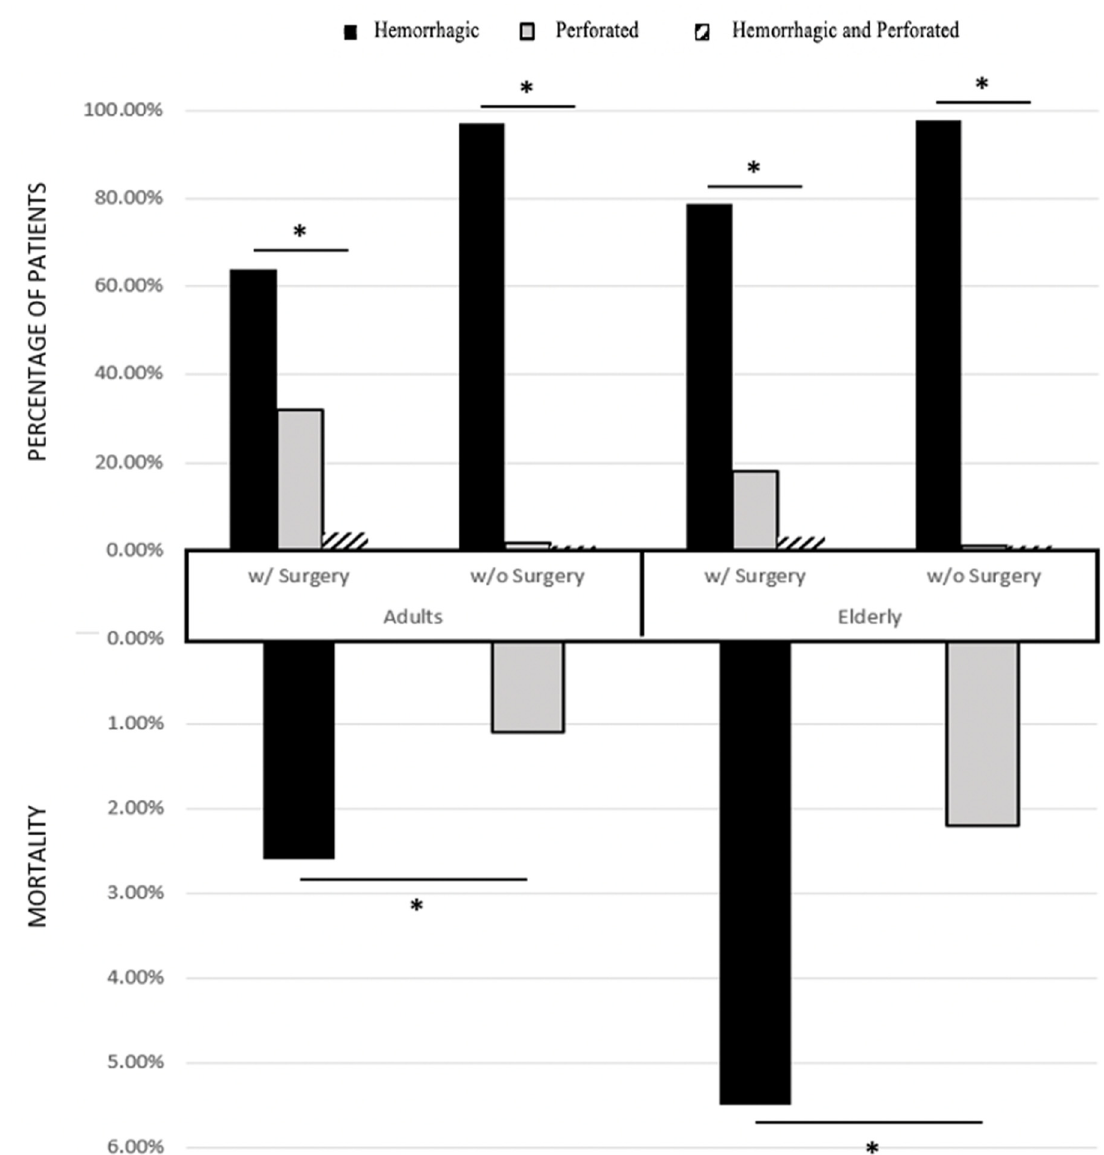
Figure 2. Comparing mortality with and without surgery. This is a comparison between the fraction of people electing or rejecting surgery with their subsequent mortality rates. The three subtypes of ulcers include: hemorrhagic ulcer, perforated ulcer, and both hemorrhagic perforated ulcers. An asterisk (*) indicates significance ( p < 0).